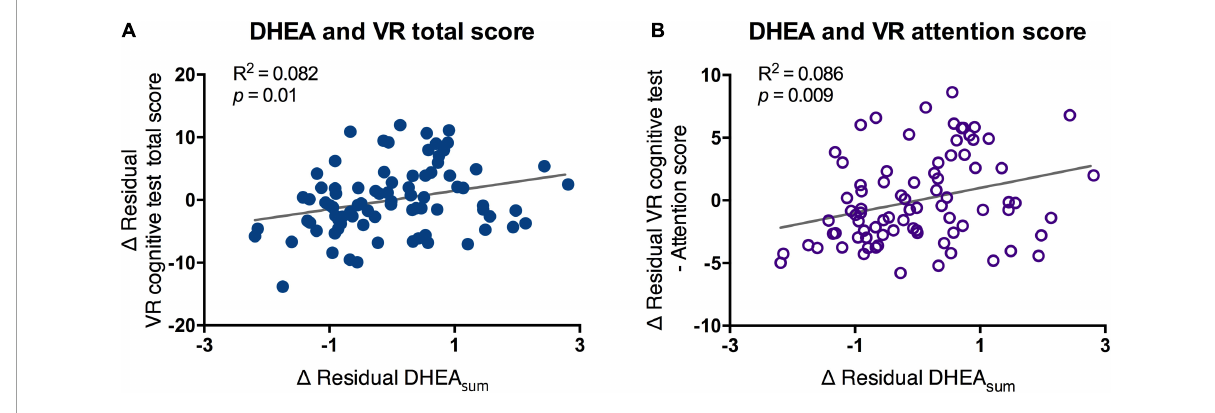
FIGURE5 Partial correlation of scores of VR cognitive test and DHEA sum . VR, virtual reality; DHEA, dehydroepiandrosterone; AUC, area under the curve. Correlation between salivary DHEA and (A) VR total score and (B) VR attention score were analyzed by partial correlation test. Line and R 2 value indicate regression of the